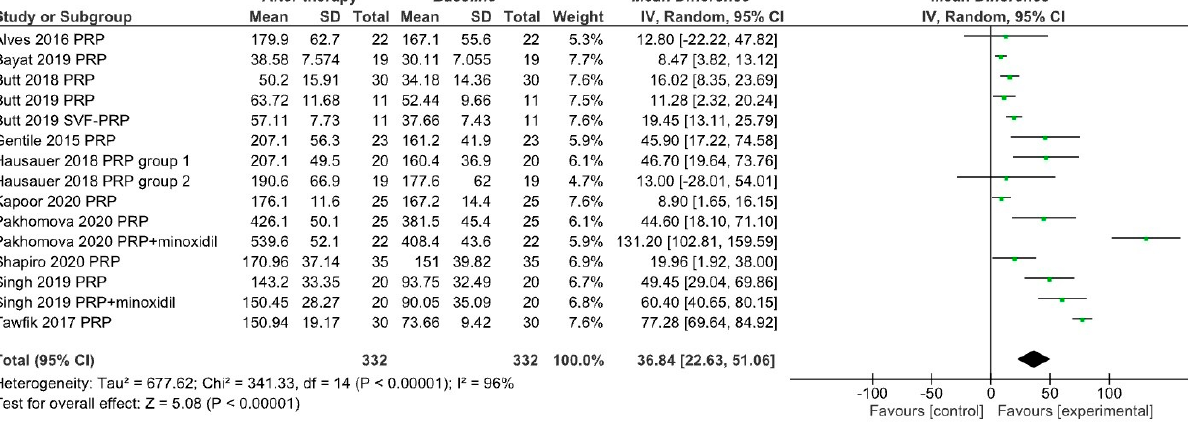
Figure 3. Forrest plot showing the effects of PRP treatment on hair density in selected study groups.